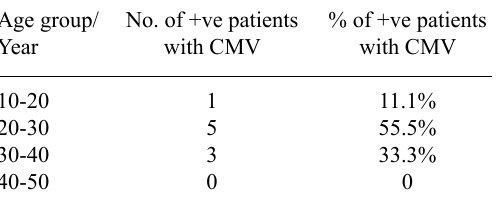
table 2. Distribution of infected